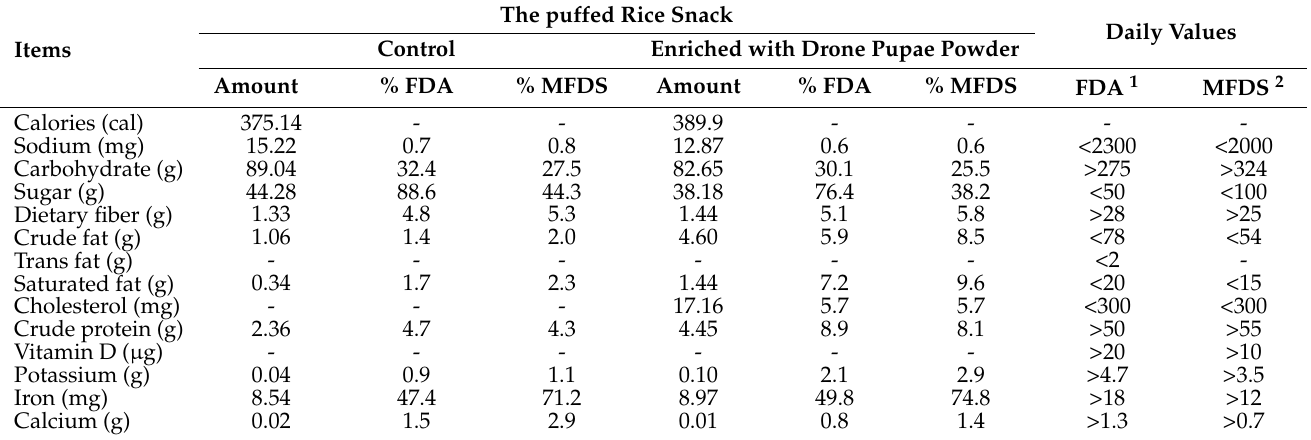
Table 13. Fourteen nutrients in the control and drone-pupae-powder enriched puffed-rice